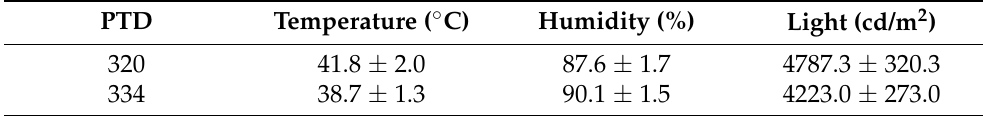
Table A1. Average values of temperature, humidity and light of the greenhouse at the different PTD.